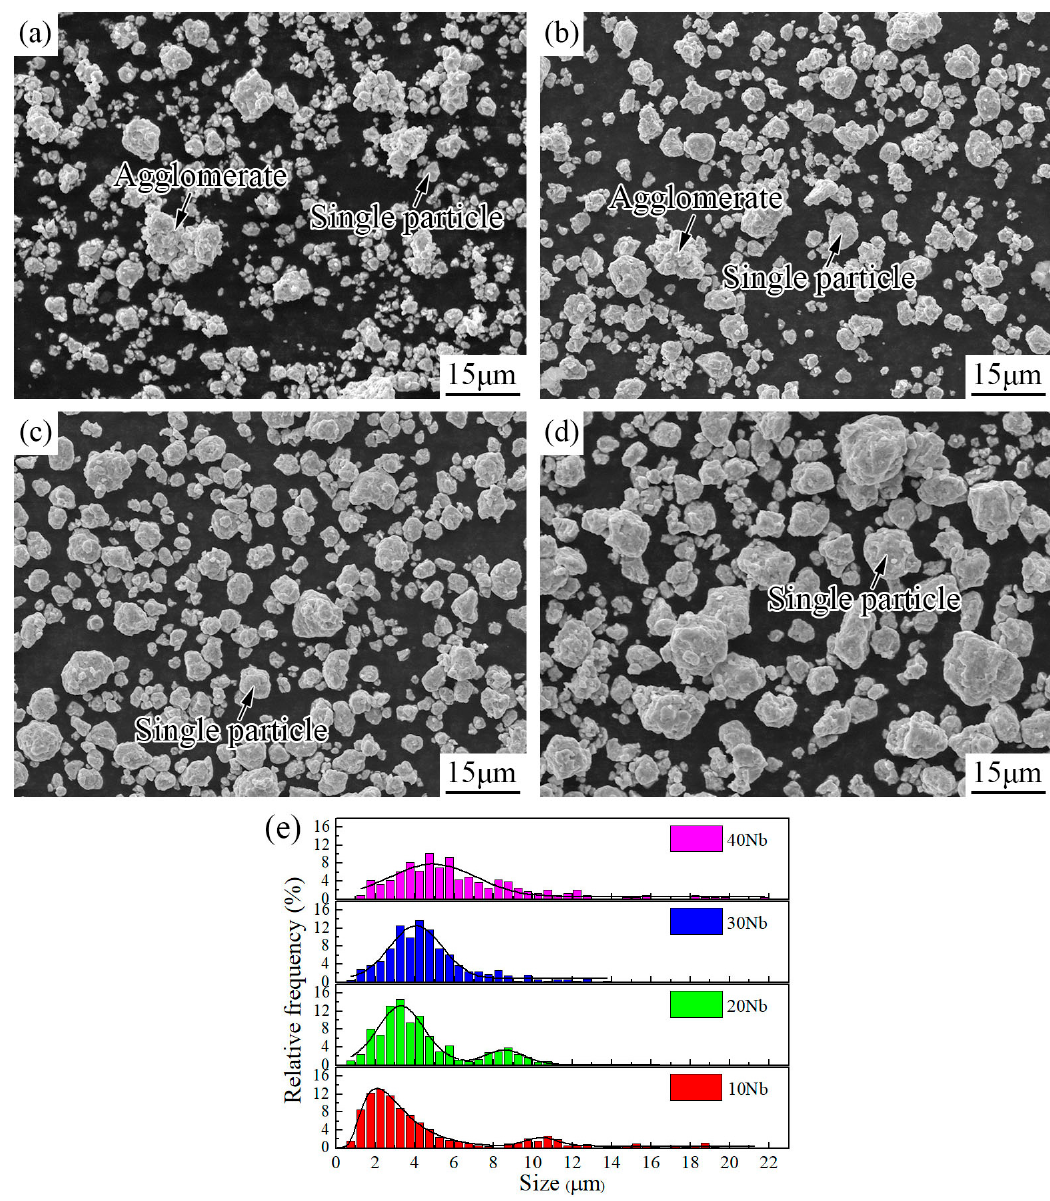
Figure 1. electron morphological images of 50 h milling powders with ( a )10, ( b )20, ( c )30, and ( d )40 Figure 1. Electron morphological images of 50 h milling powders with ( a ) 10, ( b ) 20, ( c ) 30, and ( d ) 40 at.% at.% Nb contents, and ( e ) the corresponding particle size distribution. Nb contents, and ( e ) the corresponding particle size